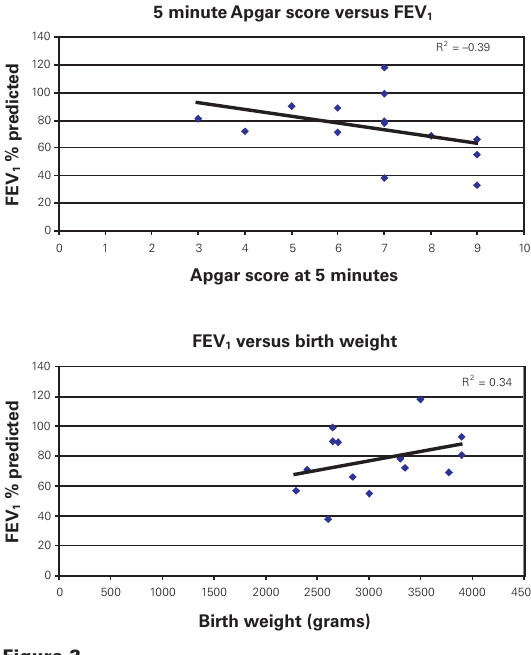
Pulmonary Function Testing at follow-up visit.